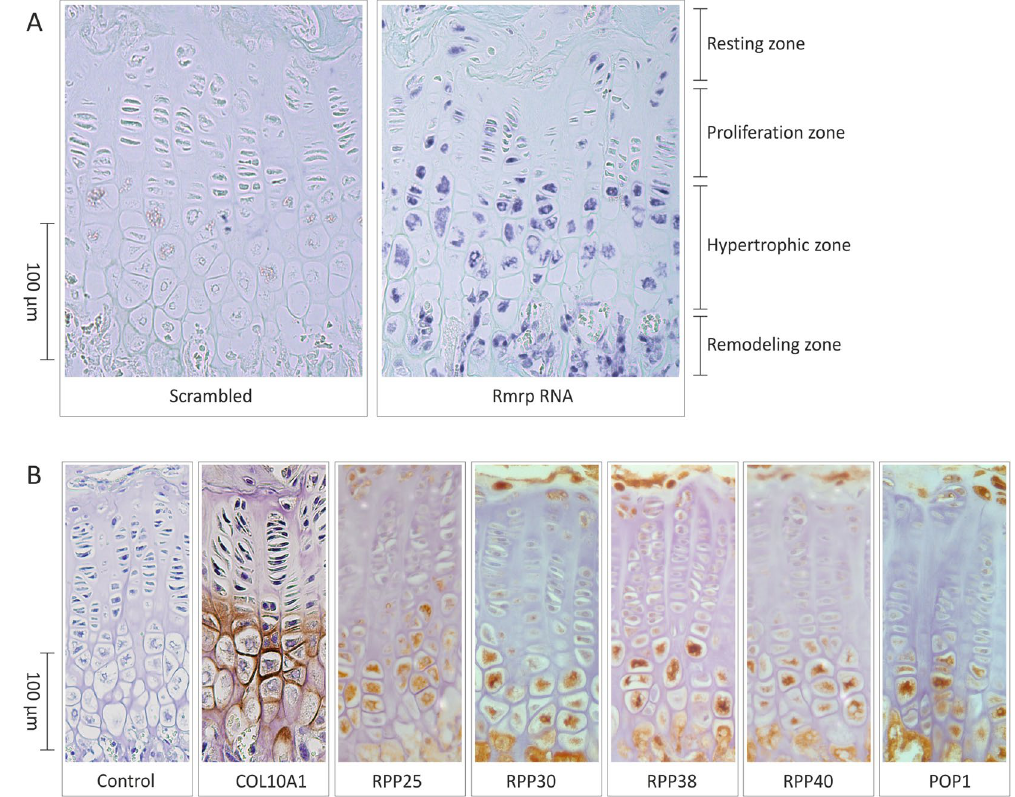
Figure 1. Spatiotemporal expression of Rmrp RNA and RNase MRP subunits in the growth plate. Five micrometer-thick formalin-fixed paraffin-embedded tissue sections were prepared from knee joint epiphyseal growth plates of 6-weeks-old mice. ( A ) Expression of Rmrp RNA was detected by in situ hybridization. A scrambled probe was used as control. ( B ) The expression of COL10A1 and RNase MRP protein subunits RPP25, RPP30, RPP38, RPP40 and POP1 was detected immunohistochemically. Figure shows representative images of the ISH ( A ) IHC ( B ) results from three individual experiments